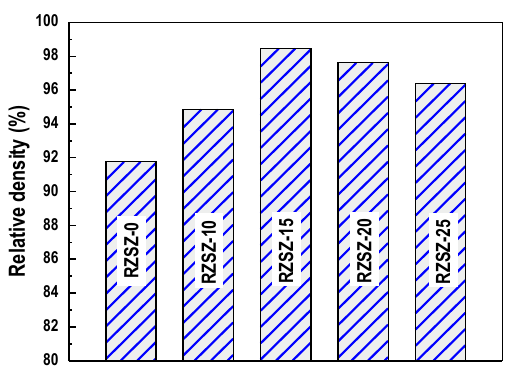
Fig. 4 Relative densities of the ZrB 2 –SiC based composites prepared by reactive hot